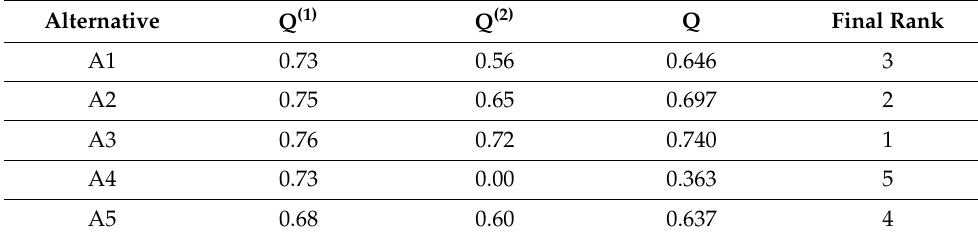
Table 16. Final ranking of the alternatives for λ =